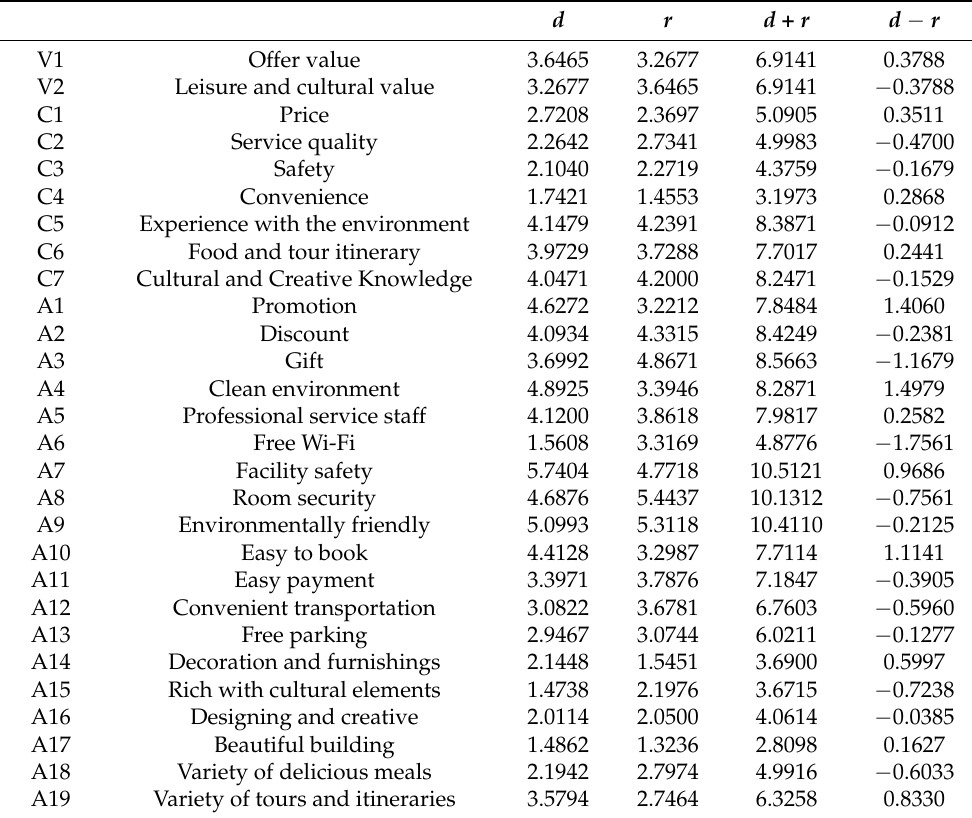
Table 5. Degree of centrality ( d + r ) and cause ( d − r ) values for each